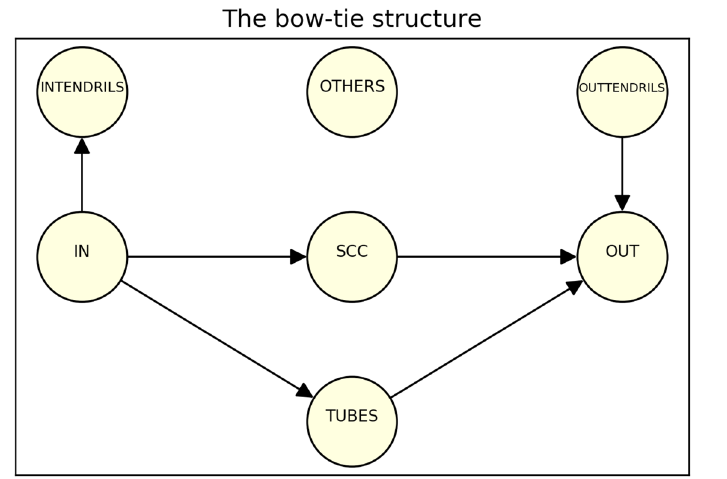
Figure 1. The seven sectors of Yang’s bow-tie